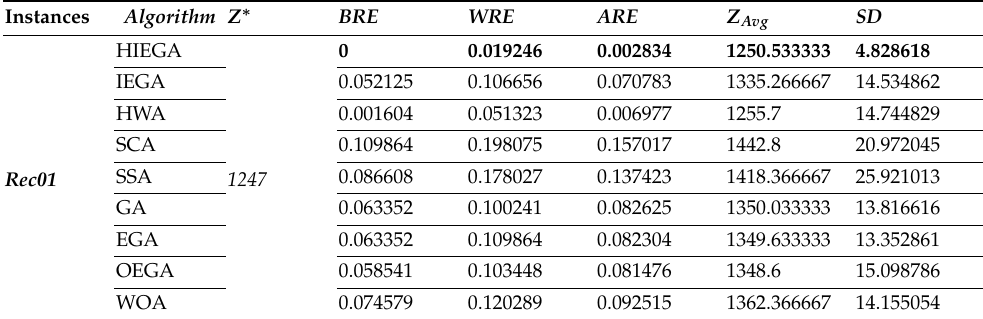
Table 5. Outcomes of different performance metrics on the Reeve instances